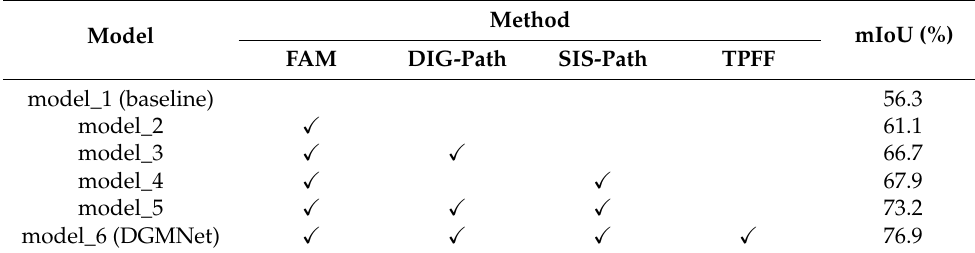
Table 1. Ablation study results of the